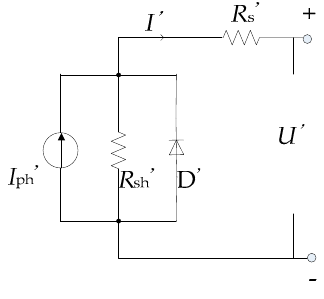
Figure 3. The equivalent circuit model of photovoltaic array.